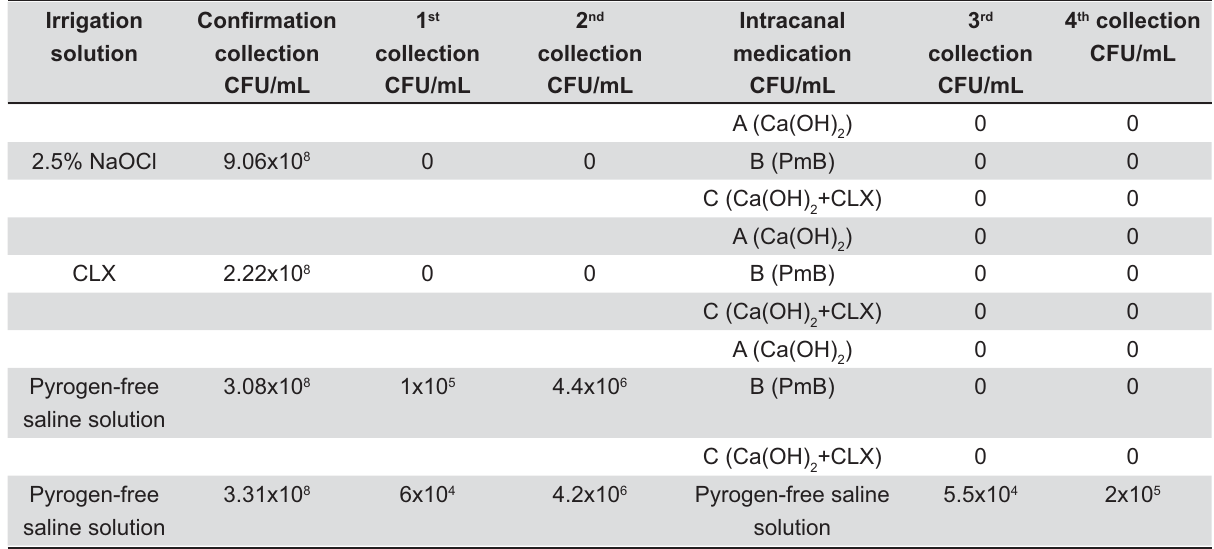
Table 1- Mean of colony forming units/ milliliter (CFU/mL) in